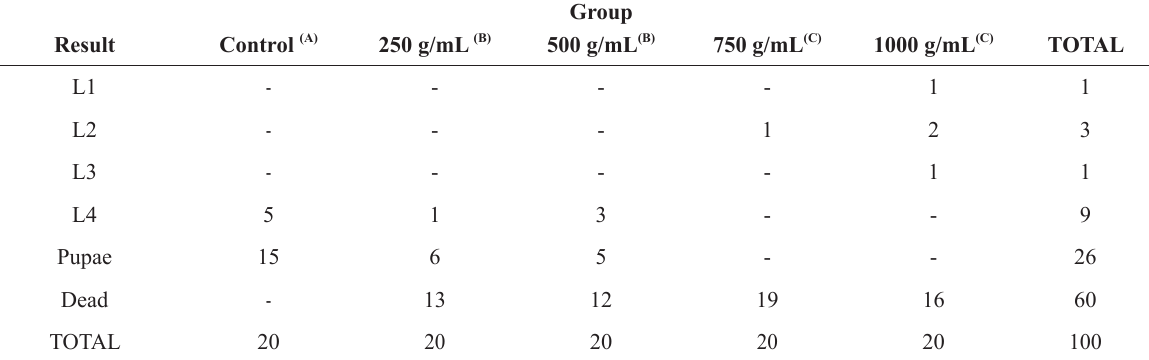
Evaluation of embryotoxic and embryostatic effects of of synthetic tannic acid in A. aegypti larvae over 14